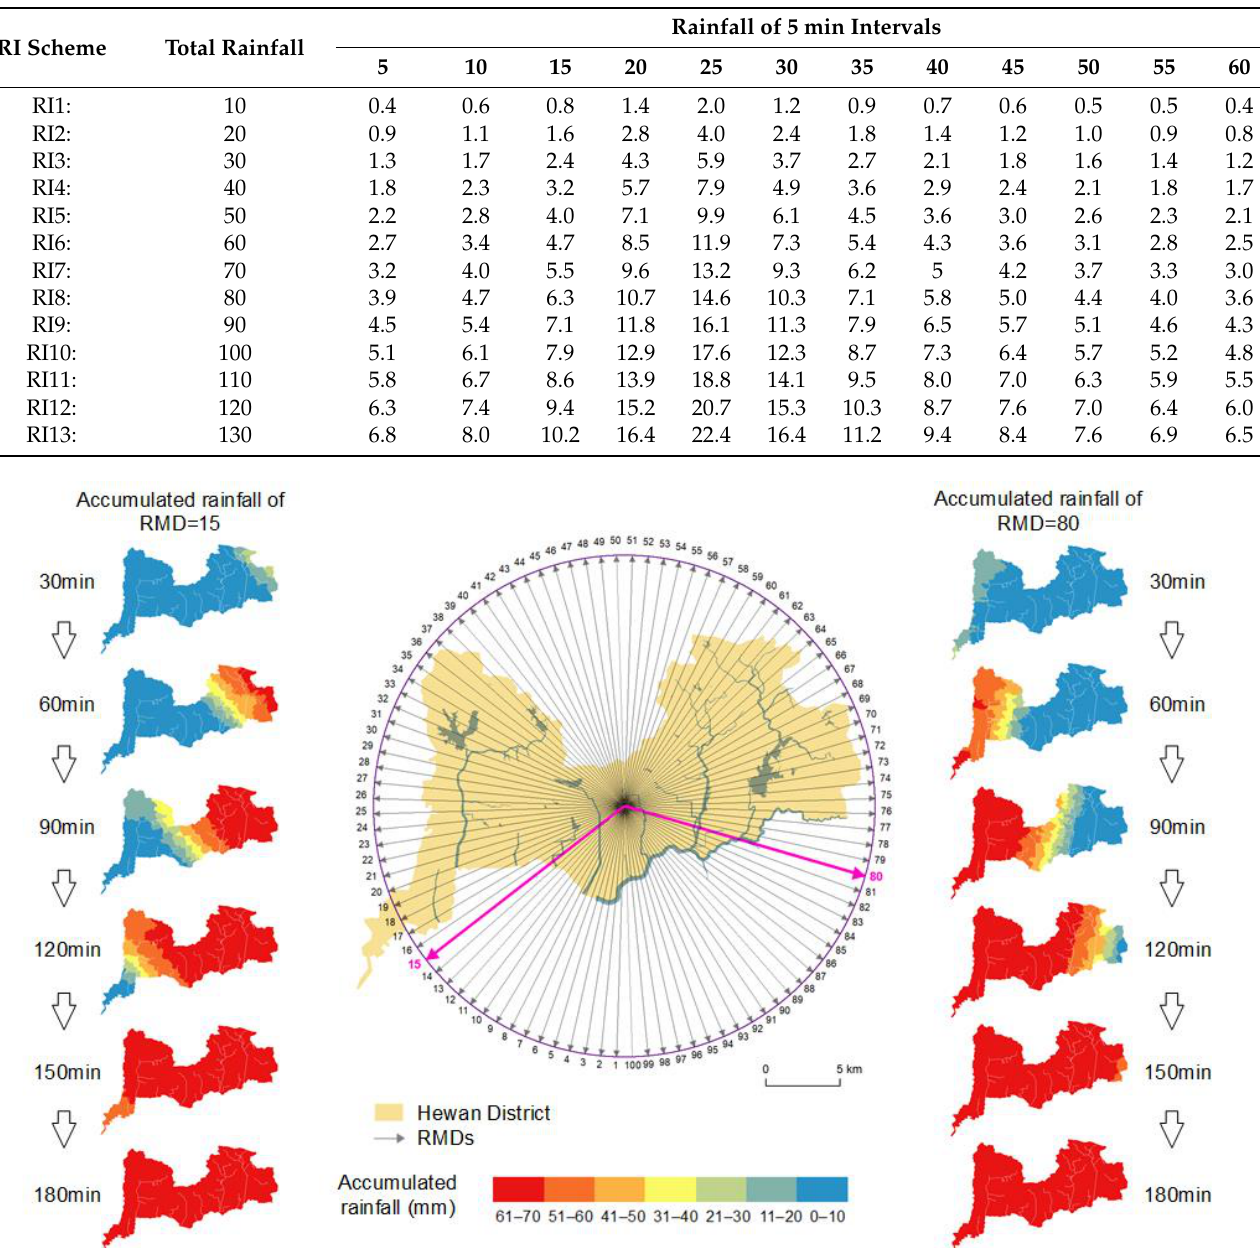
Table 1. Rainfall process of 13 rainfall intensity schemes.